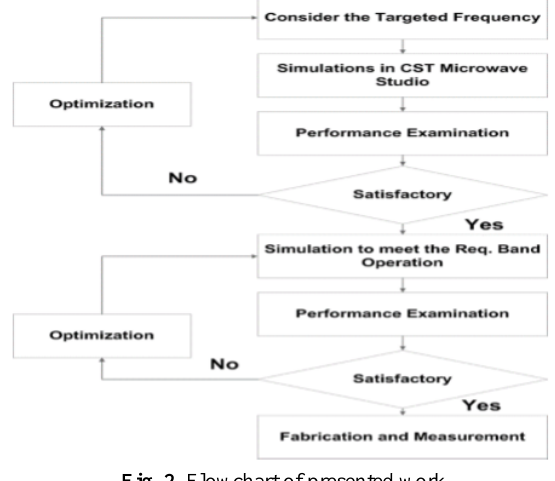
Fig. 2. Flowchart of presented work The parameters of the patch, substrate and truncated ground plane are given in Table II.